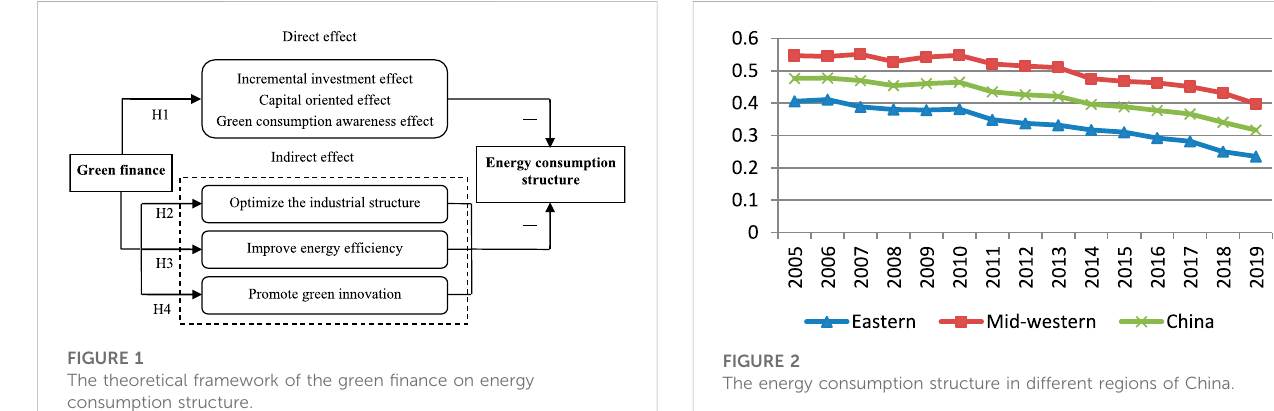
FIGURE 1 The theoretical framework of the green fi nance on energy consumption structure.